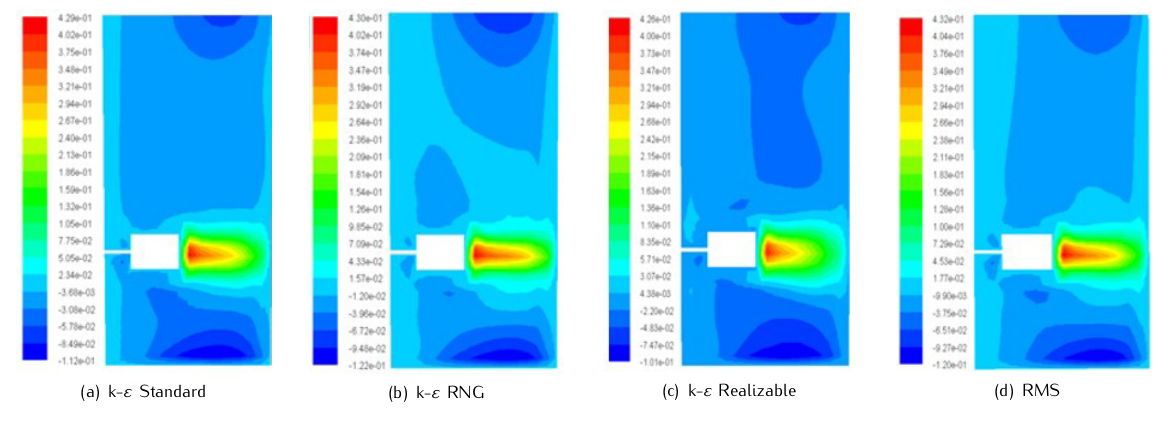
Figure 4. Distribution of the radial velocity in r-z plane.